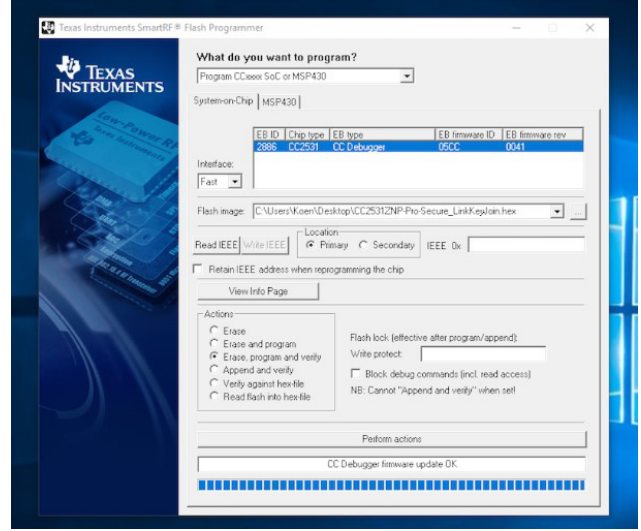
Figure A2. Patching the USB dongle through SmartRF Flash